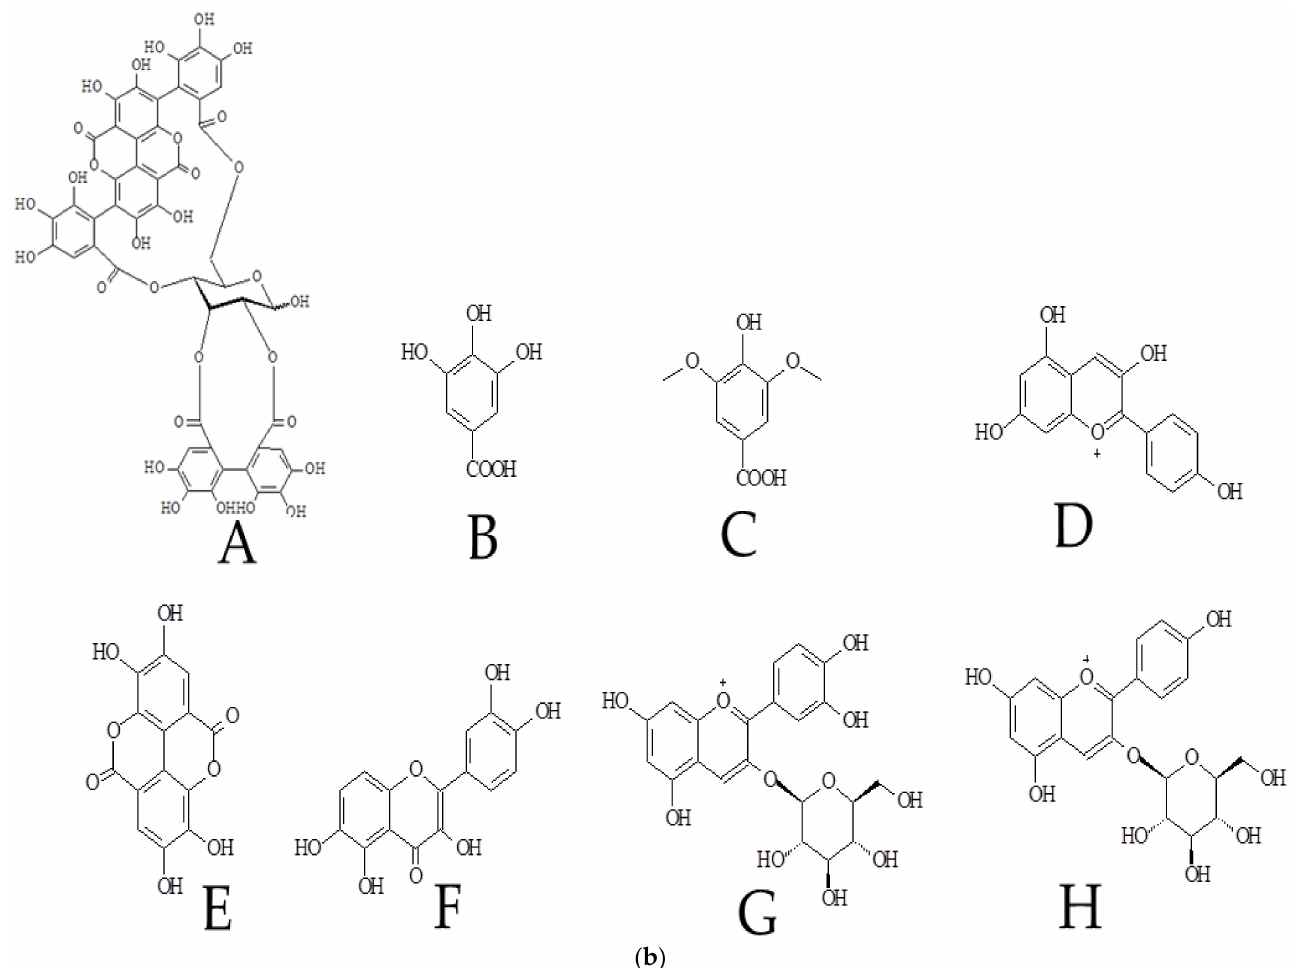
Figure 3. ( a ) Phenolic compounds of P. granatum peel powders by LC-MS/MS. ( b ) Chemical struc- ture of the phenolic compounds in P. granatum peel extract. A: α - and β -Punicalagin; B: Gallic Acid; C: Syringic acid; D: Pelargonidin; E: Ellagic acid; F: Quercetin; G: Cyanidin-3-O-glucoside; H: Pelardonidin 3-O-glucoside.